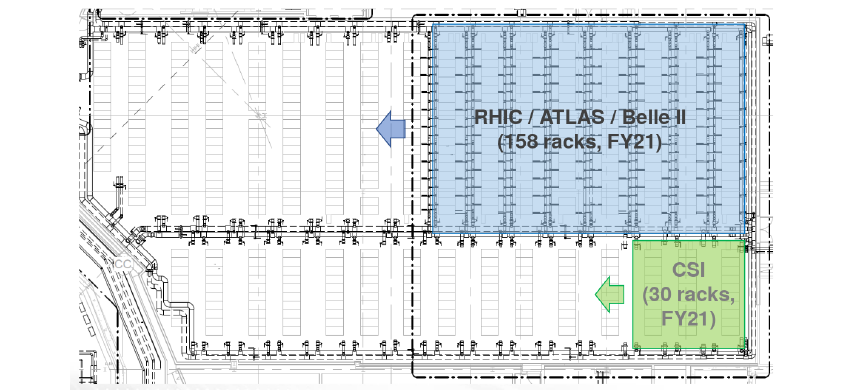
Figure 2. New Data Center - Main data hall floor plan